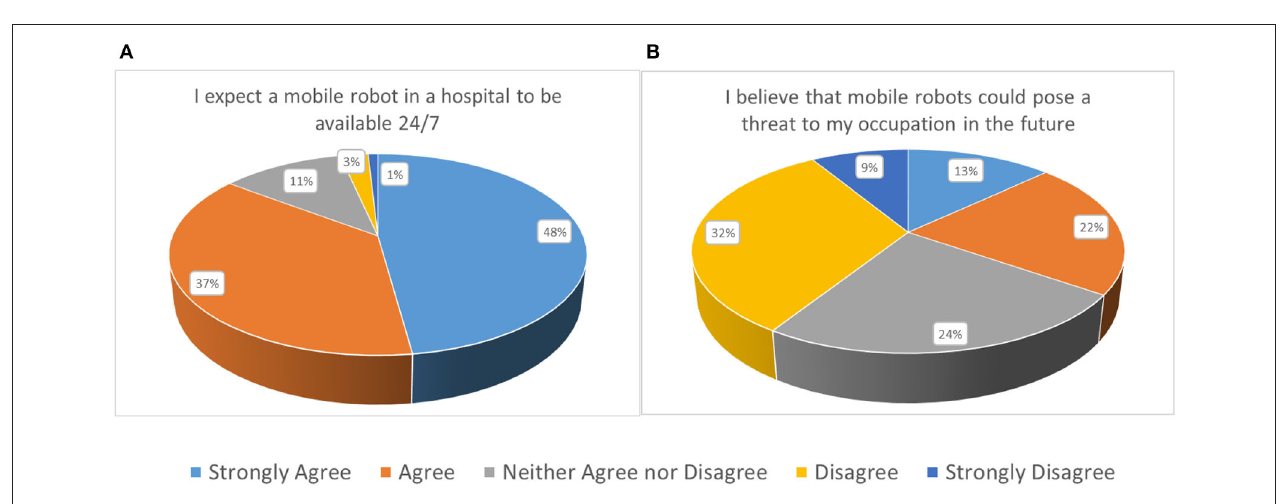
FIGURE 4 | (A) Subjective norm and (B) Safety and privacy